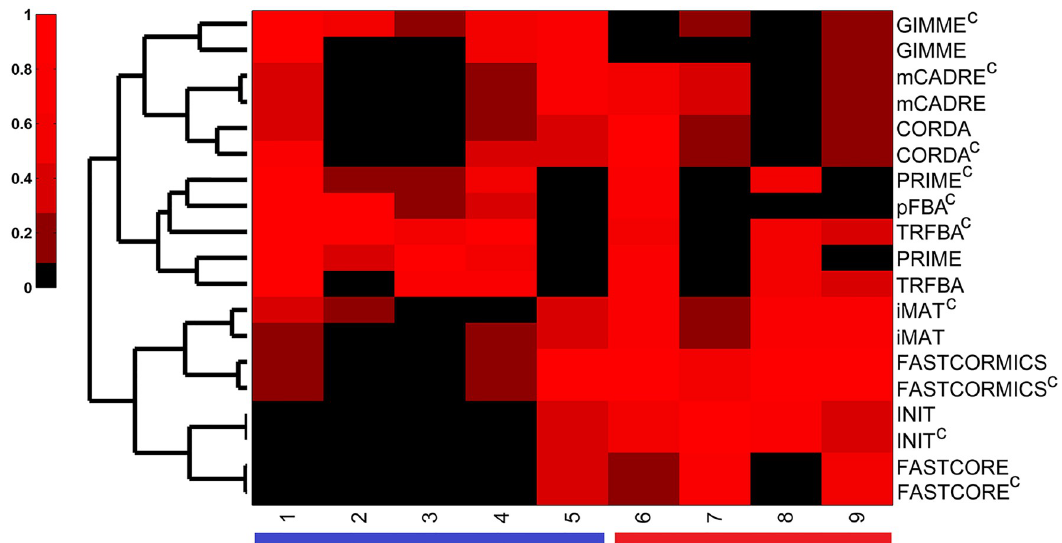
Fig 11. Benchmark performance scores for algorithms under study. Hierarchical clustering (Euclidean distance) of the scores each method received over different benchmarks. Three main clusters were identified: 1- GIMME, CORDA and mCADRE with an overall weak to moderate performance; 2- PRIME, TRFBA and pFBA c with strong performance in comparison tests, and 3- FASTCORE, INIT, iMAT and FASTCORMICS with strong performance in consistency tests. Numbers in column correspond to comparison (blue color) or consistency (red color) benchmarks: 1-growth rate, 2- metabolite uptake/secretion rates, 3- drug response, 4- essential genes, 5- enrichment of OG/TS/LOFs, 6- fraction of blocked reactions, 7- resolution power, 8- robustness to missing data, and 9- robustness to noise. Colorbar indicates normalized performance